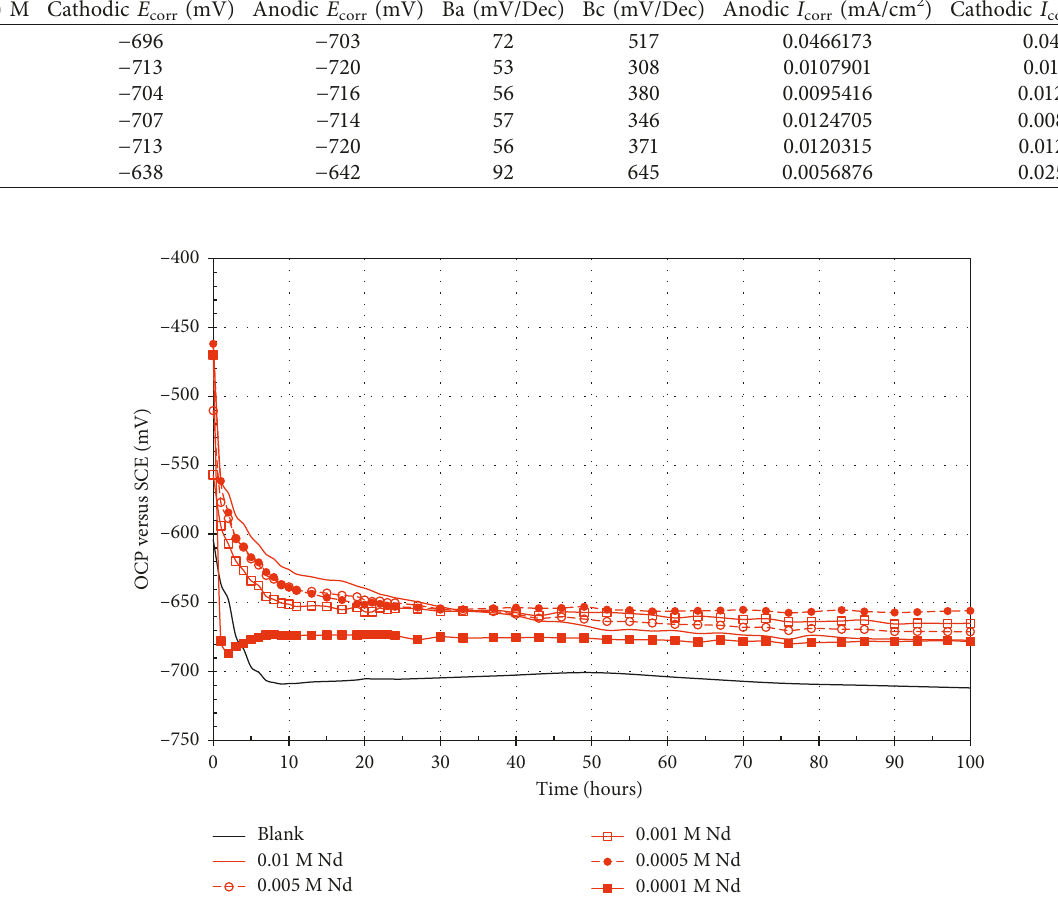
Figure 3: Variation in OCP values for API X70 steel in 3.5% NaCl solution at different concentrations of Nd 3+